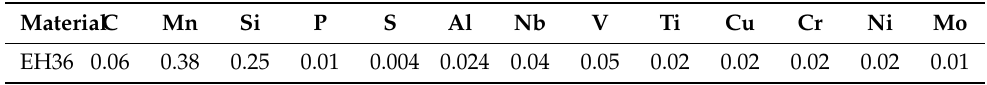
Table 2. Chemical composition of EH36 HSLA steel.